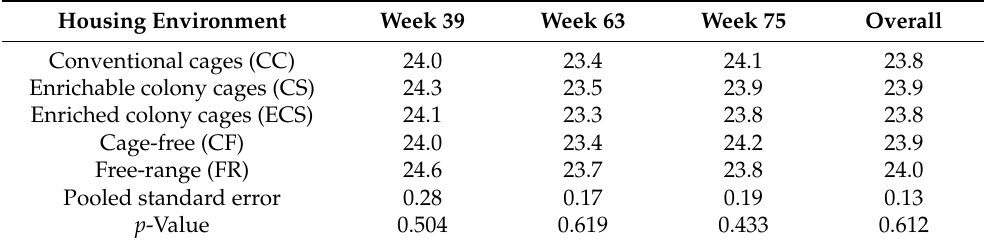
Table 12. The effect of housing environment on whole-egg solid percentage of brown egg layers by week and